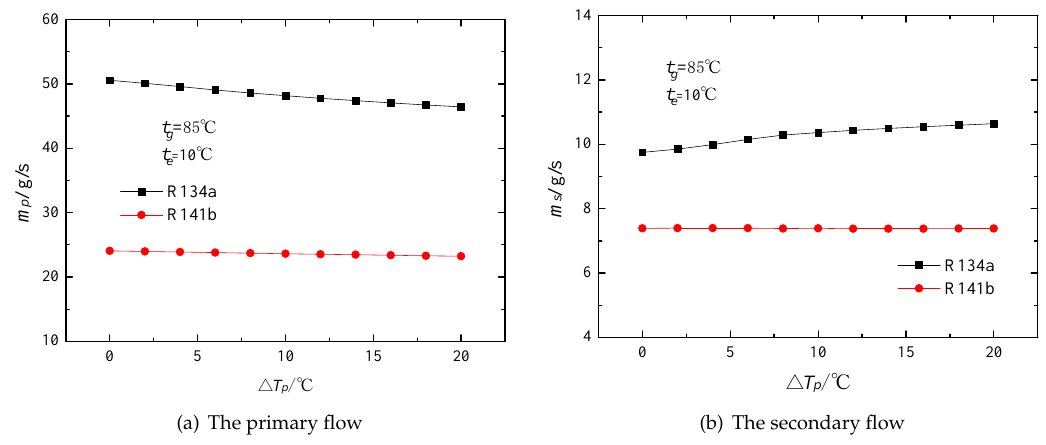
Figure 12. The flow rates of the primary and secondary flows versus the primary superheating (cid:52) T p .